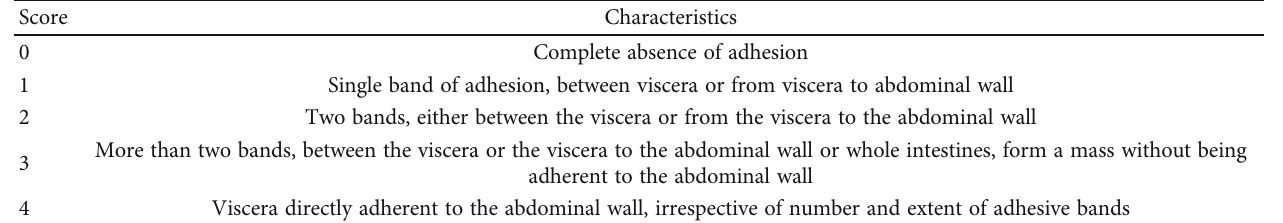
Table 1: Nair ’ s macroscopic adhesion classi fi